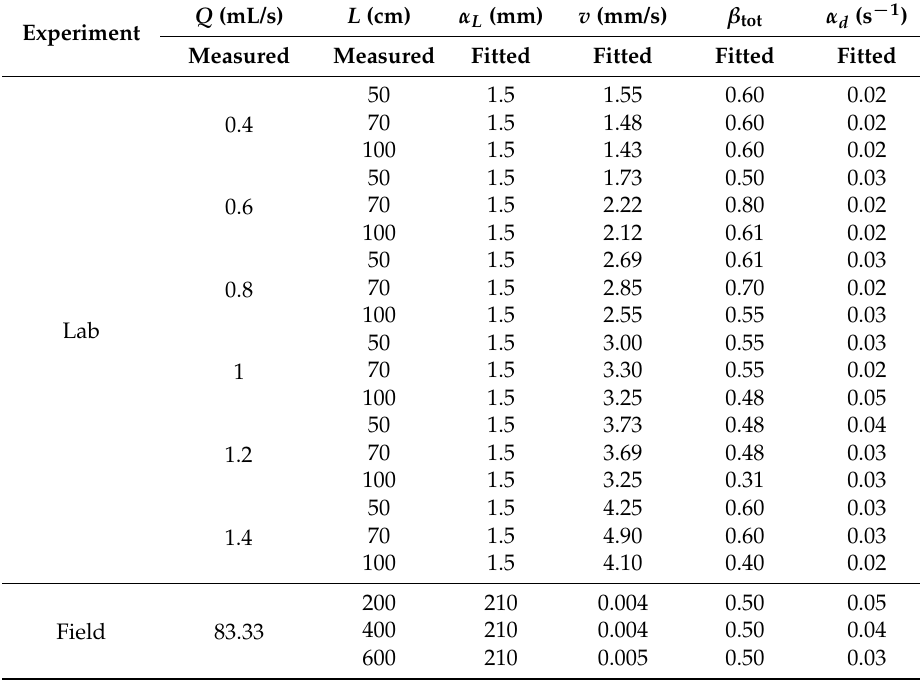
Table 3. The fitted parameters for the single diffusion rate multi-rate mass transfer (MRMT) model at different flow rates and travel distances. In the legend, α d is the diffusion rate coefficient ( α d = D a /a 2 , where Da is the apparent diffusion coefficient and a is the layer